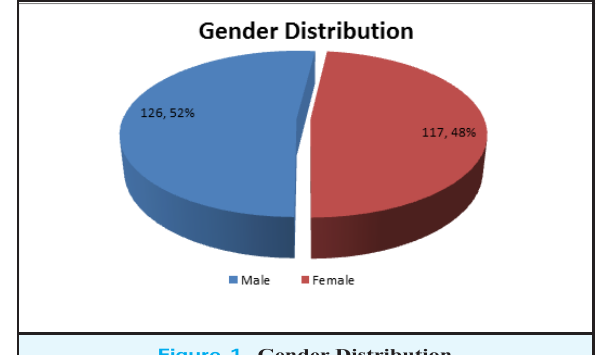
Figure 1. Gender Distribution Paired samples correlation table was constructed to assess the correlation of waist hip ratio with random blood sugar level in both sexes; it was observed that